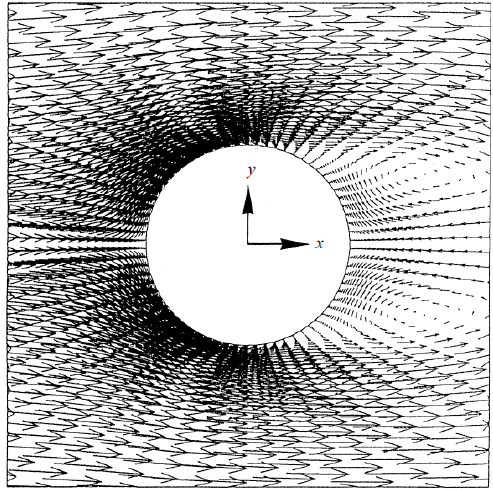
Figure 3. Uplift due to shear stresses on a particles surface. Reprinted with permission from [36]. 2021 Hanmaiahgari, P.R.